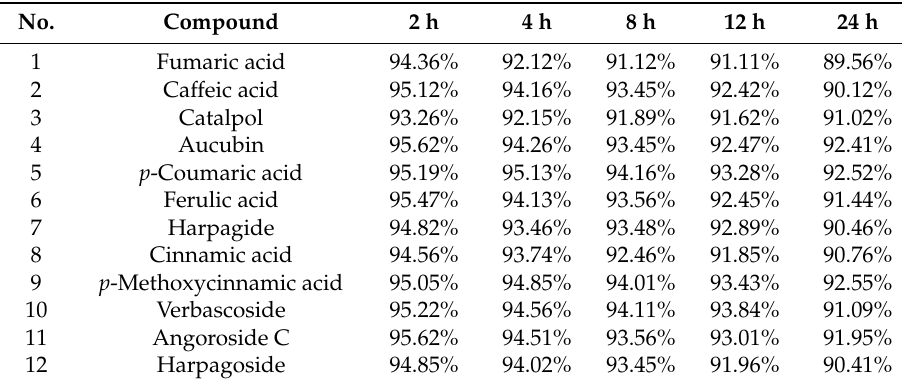
Table 4. Stability of the 12 investigated